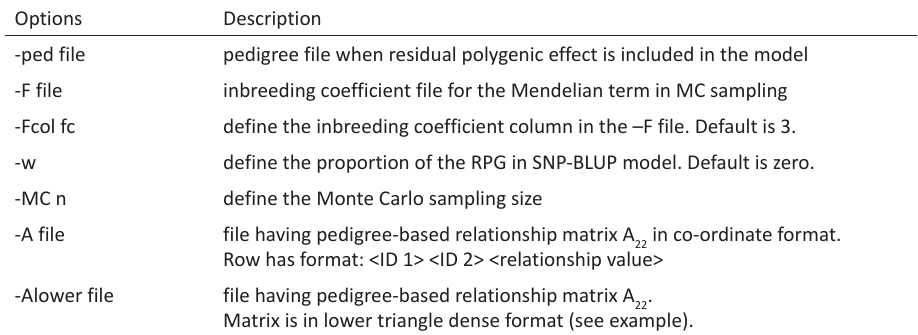
Table 2. Snp_blup_rel options when including RPG effect using exact SNP-BLUP or MC-SNP-BLUP